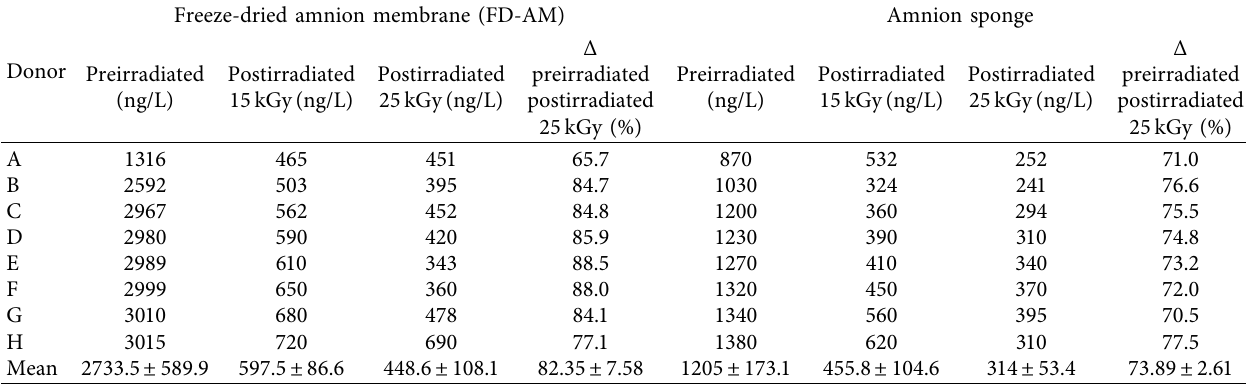
Table 4: TGF- β levels in the freeze-dried amnion membrane (FD-AM) and amnion sponge before and after radiation sterilization.